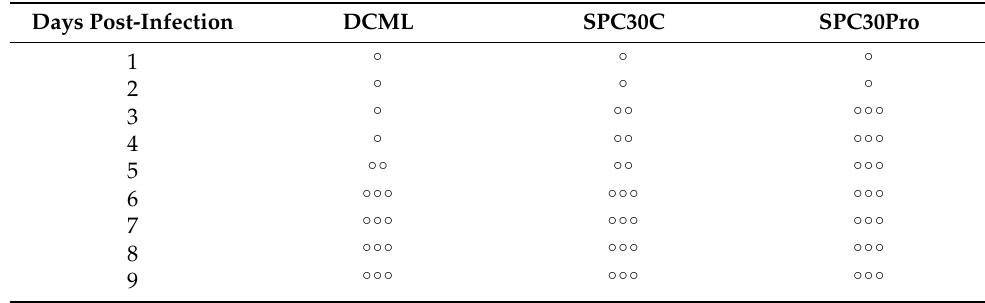
Table 4. Totoaba macdonaldi motility after Vibrio harveyi